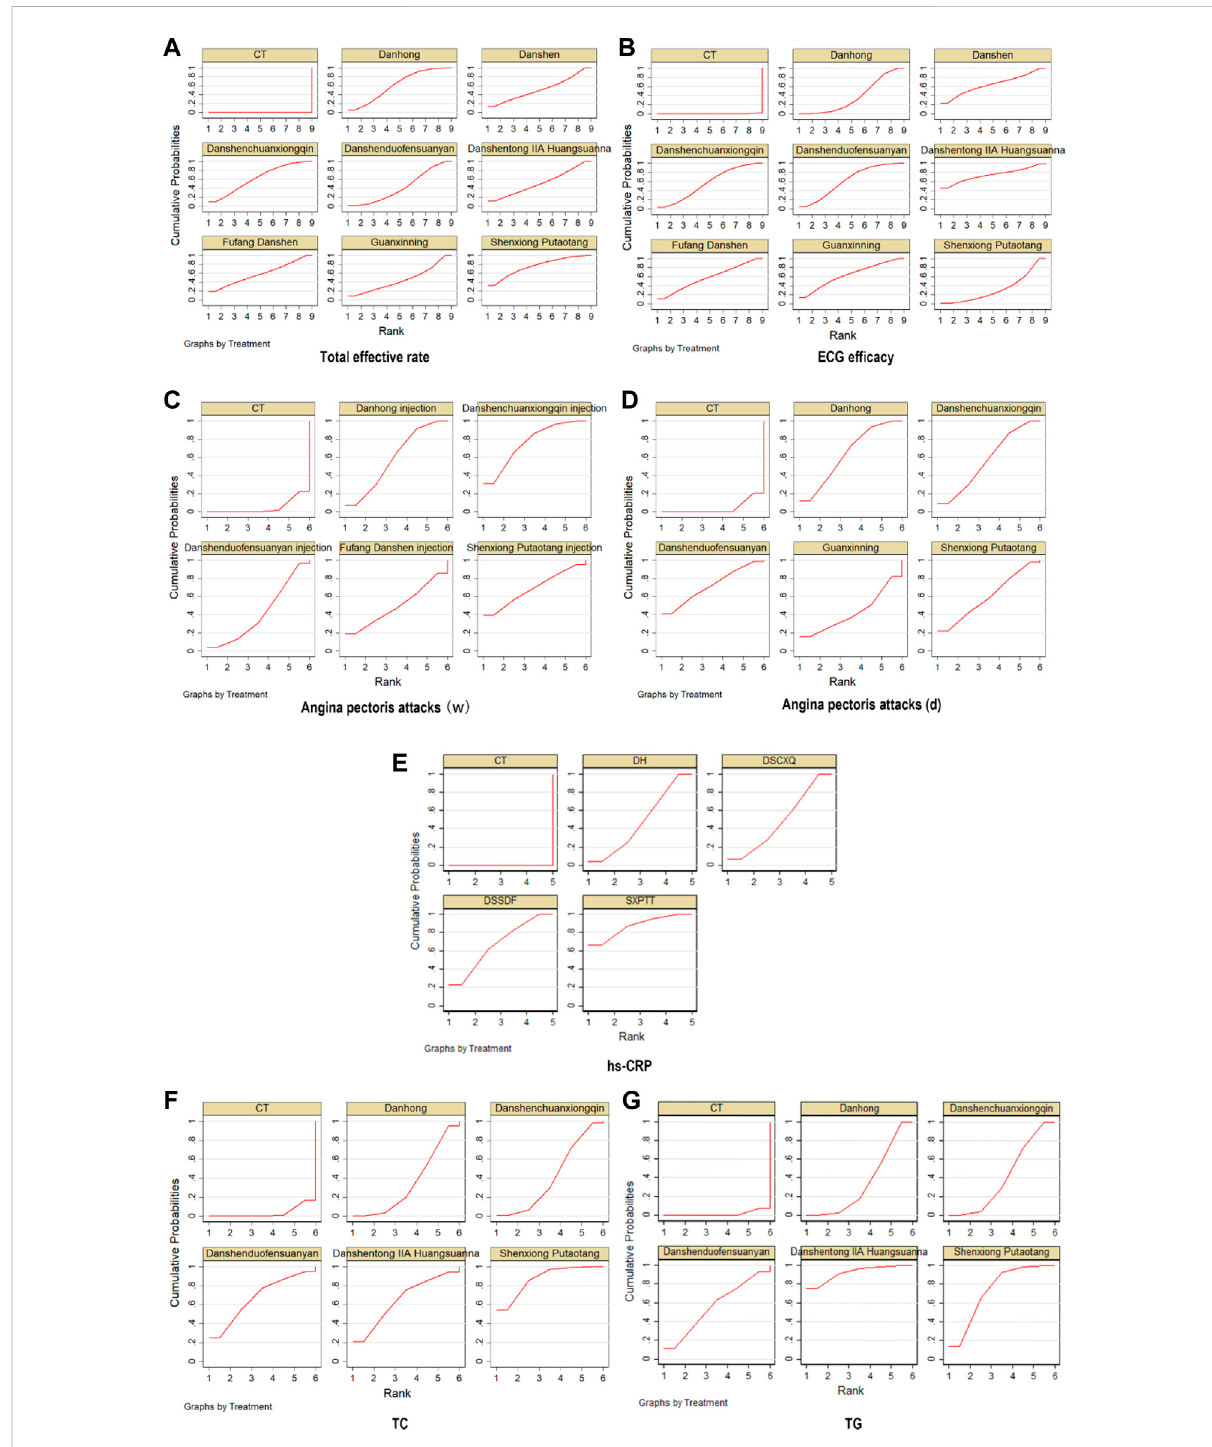
FIGURE 6 SUCRA ofcomparisonsondifferentoutcomesoftreatmentsindifferentgroupsofpatients with UA. (A) totaleffective rate; (B) ECGef fi cacy; (C) Angina pectoris attacks (weeks); (D) Angina pectoris attacks (days); (E) hs-CRP; (F) TC; (G)